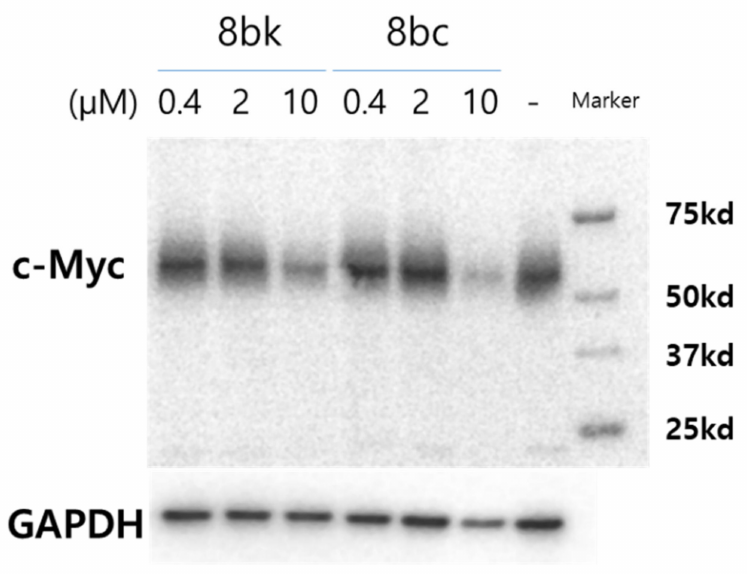
Figure 3. NALM6 cells were treated with 8bk or 8bc compounds. After 18 h, cell lysates were prepared, and western blot was conducted to see c-MYC